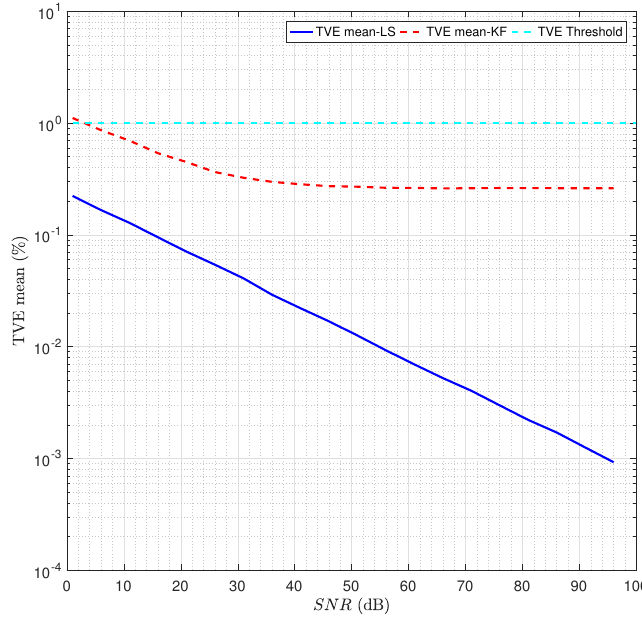
Figure 3. Mean TVE versus